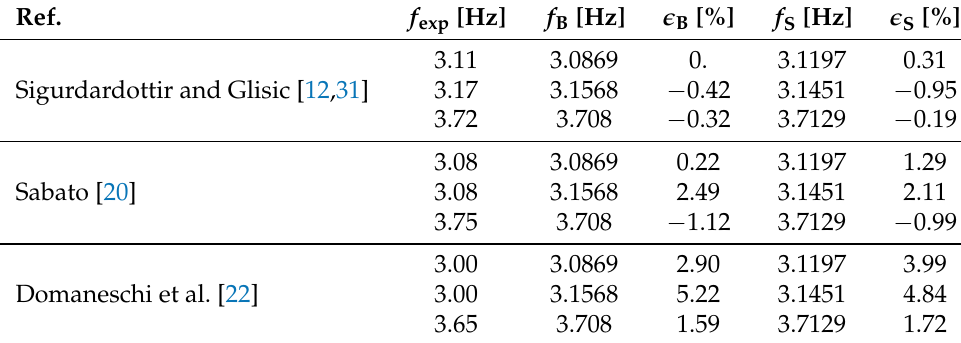
Table 9. Comparison between experimental and numerical